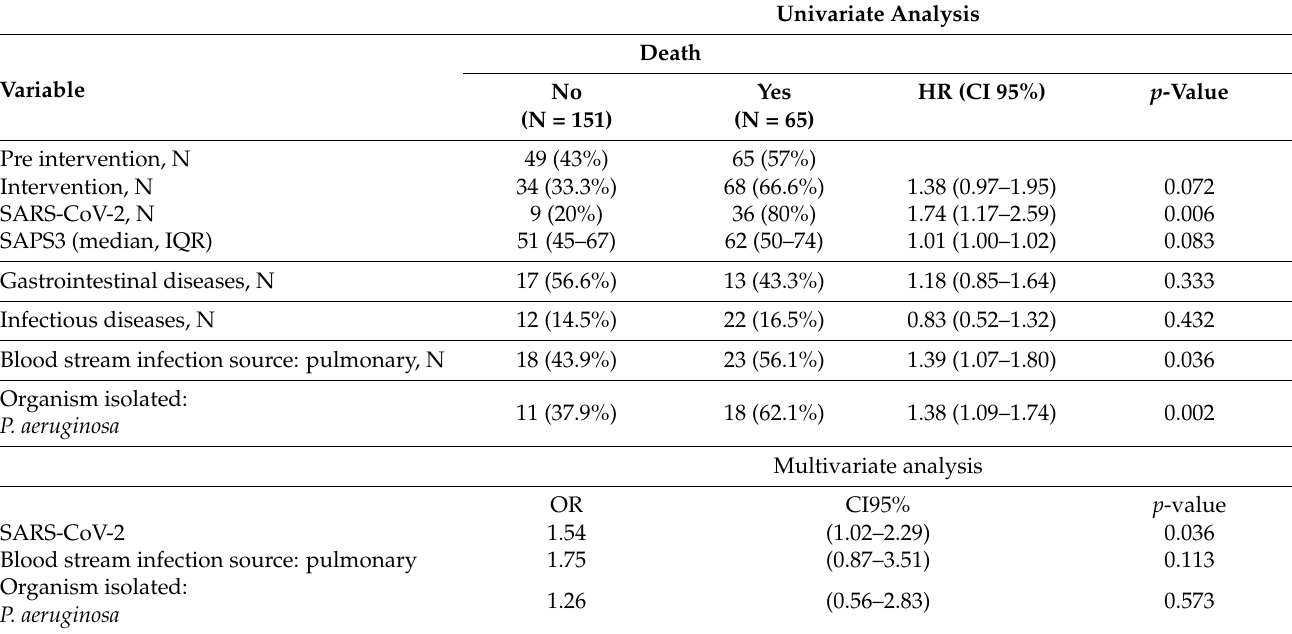
Table 3. Univariate and multivariate analysis of the risk factors of 30-day mortality in patients included in the